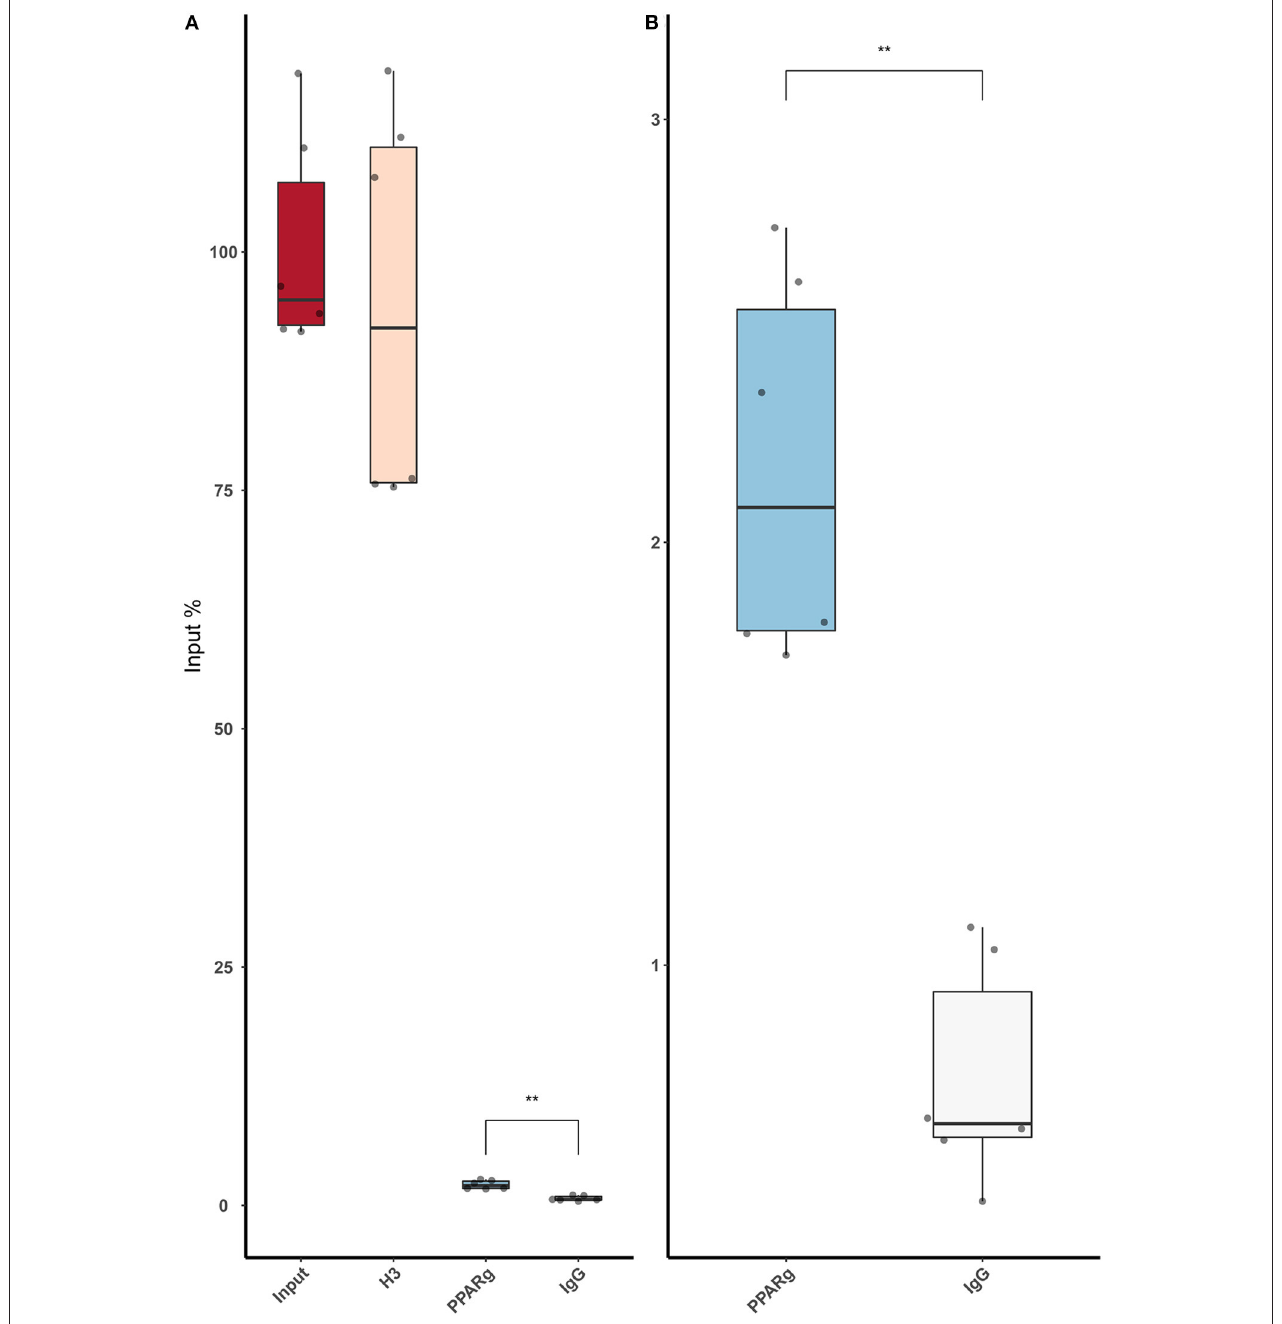
FIGURE 5 | ChIP-qPCR using an anti-PPAR γ antibody demonstrates that low amounts of PPAR γ binds around rs397751713. (A) Full plot with the input chromatin used in the assay, a positive control (H3), and a Rabbit IgG. (B) Comparison between the control IgG and PPAR γ amplification. Data are shown as box plots representing median ± quartiles. Dots represent technical replicates from two biological replicates. A Student’s t -test was used for statistical analysis (** p > 0.01). PPAR γ , peroxisome proliferator-activated receptor γ .